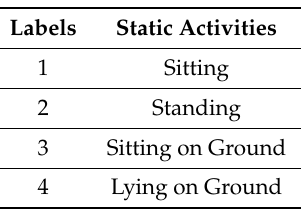
Table 8. Static activity